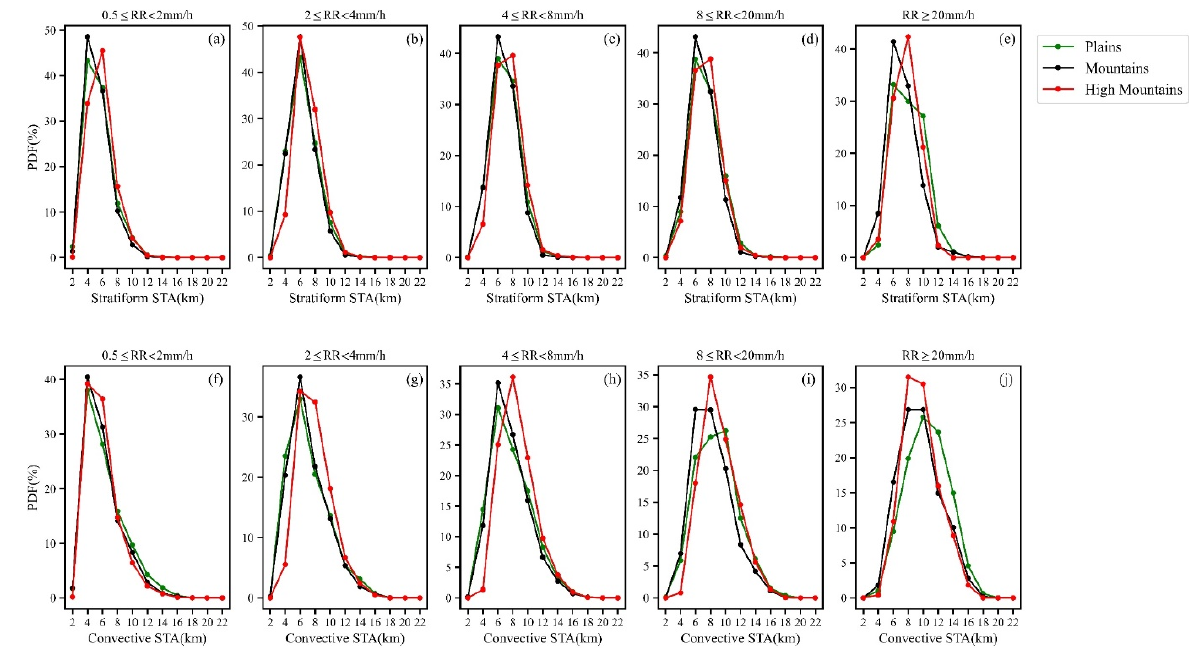
Figure 11. Probability distribution functions (PDFs) of storm top altitude with various near-surface RR of SP ( a – e ) and CP ( f – j ) over different topographic. The green, black and red solid lines represent plains, mountains and high mountains, respectively.